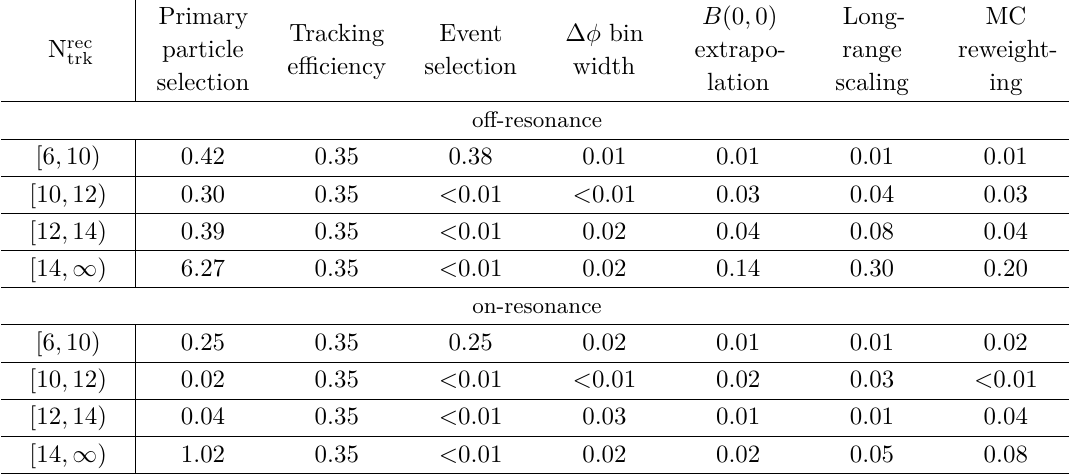
Table 3. Beam axis analysis systematic uncertainties for the off-resonance and on-resonance data as a function of the reconstructed-track multiplicity N rec the long-range differential associated